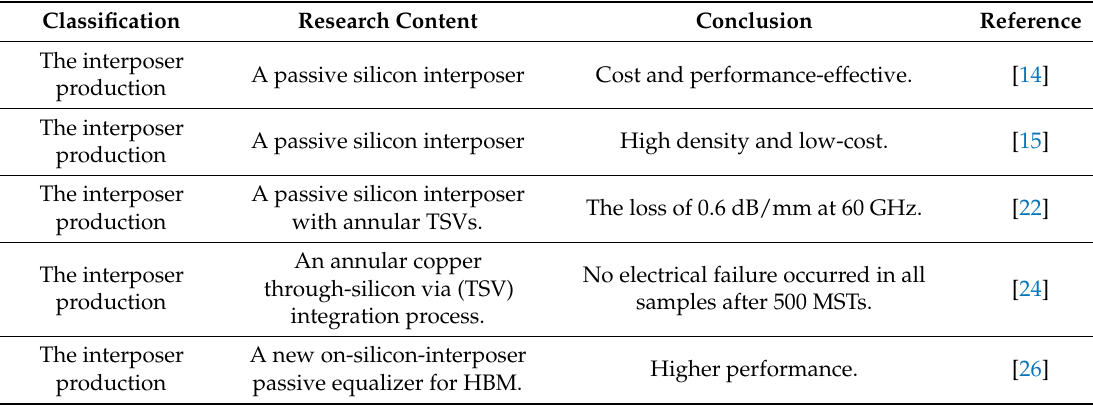
Table 4. The TSV and interposer technology